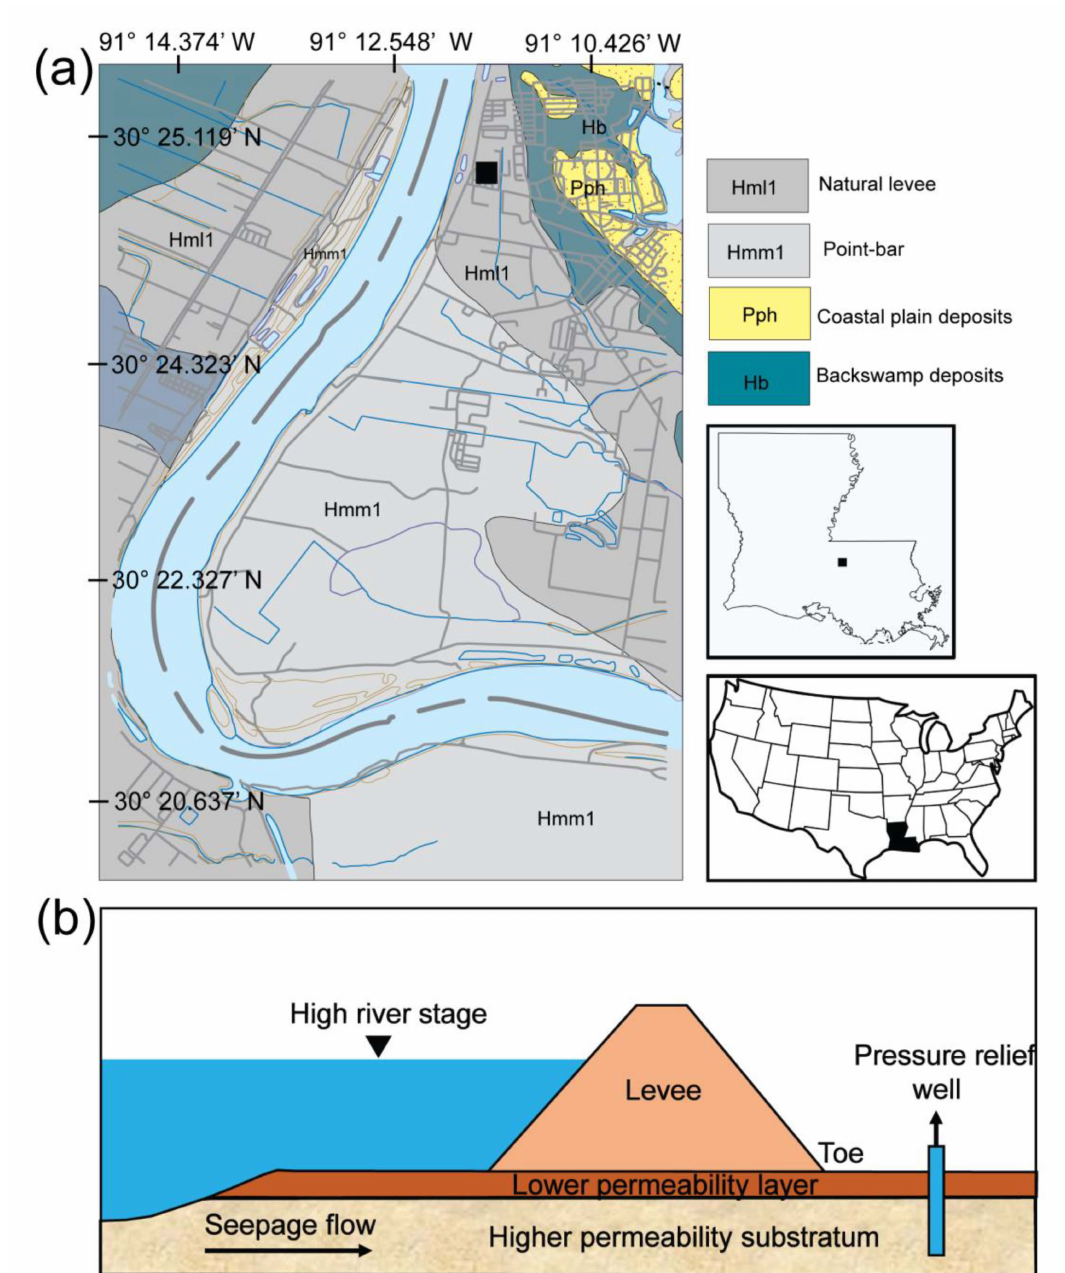
Figure 1. ( a ) Regional location and sedimentary setting. The study area (black box) along the northern Gulf of Mexico Coast, USA, lies west of the city of Baton Rouge, Louisiana (right insets). Mapped surface sedimentary facies [7] are expected to represent near-surface (0–40 m) sediments. ( b ) Schematic view of confined flow under a levee (adapted from